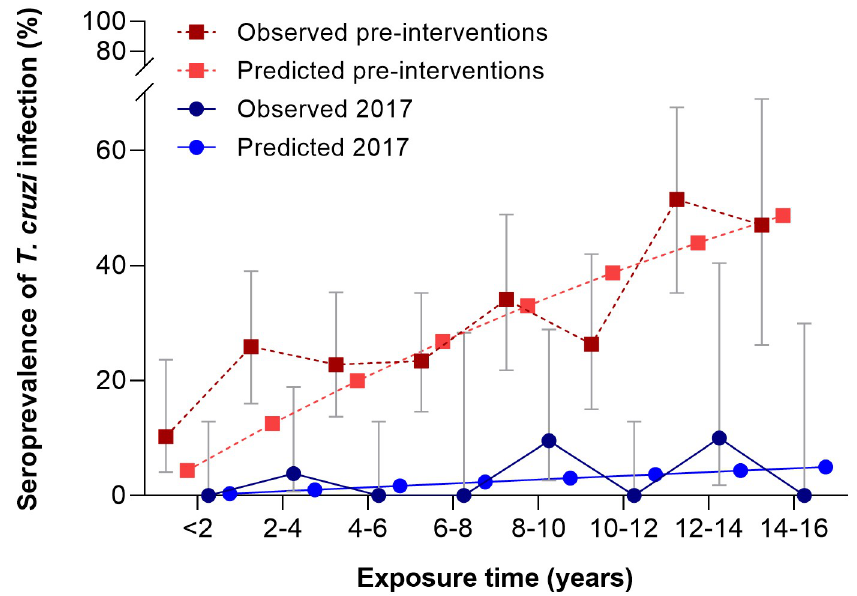
Fig 3. Observed and predicted (irreversible catalytic model) seroprevalence of Trypanosoma cruzi in children with less than 16 years of exposure before interventions and in 2017, Pampa del Indio, Chaco.